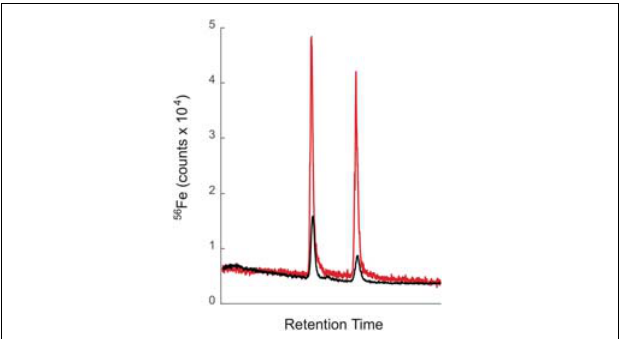
FIGURE 3 | LC-ICPMS Fe chromatograms of ferrichrome and ferrioxamine E (2 nmol each) showing the better sensitivity and decreased solvent effects of the low-flow/make-up flow system (red trace) compared to the high-flow/split system (black trace). The low flow/make-up flow system was eluted with a flow rate of 10 µ l/min with a make-up flow of 35 µ l/min pH 2 qH2O. The high-flow/split system was eluted with a flow rate of 200 µ l/min, which was split post-column with, 20% entering the ICPMS, 80% going to